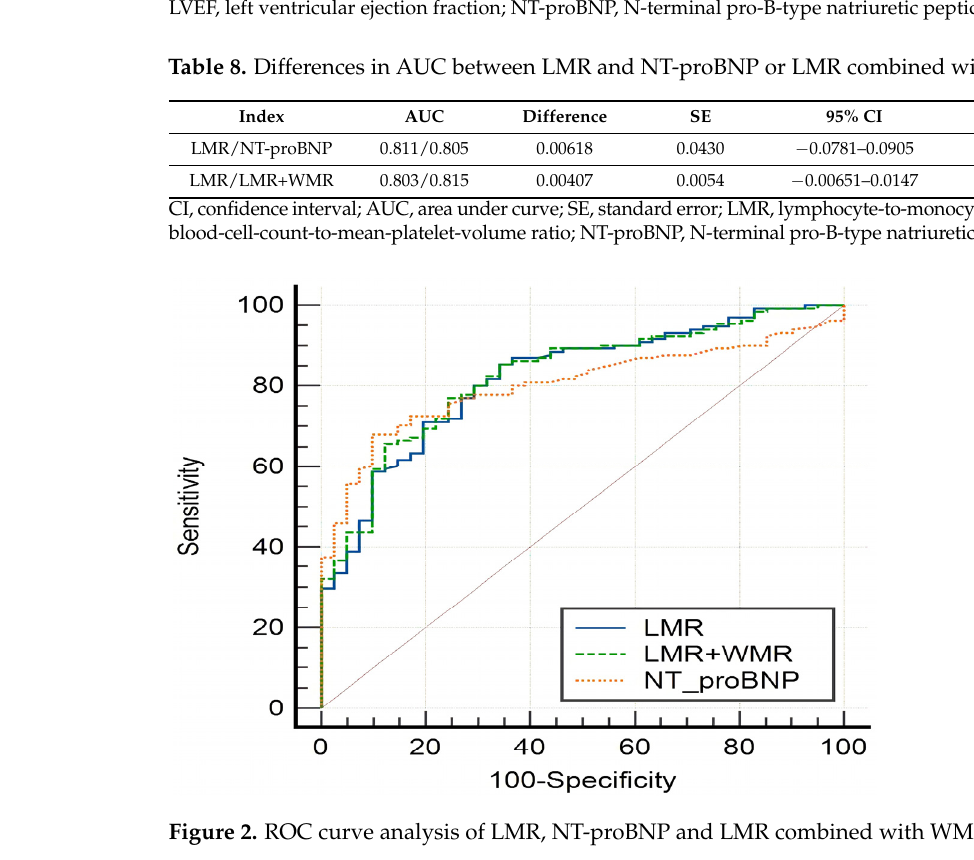
Table 7. ROC curve analysis of SII for diagnosis of HFpEF.